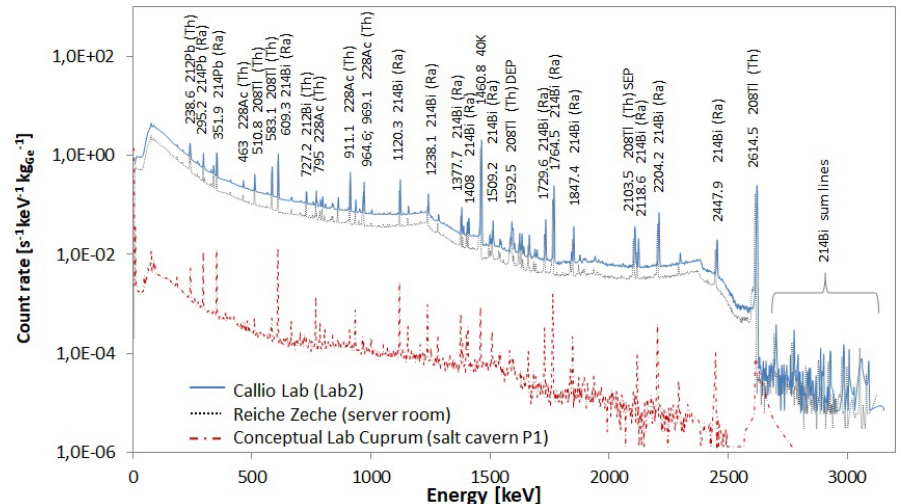
Figure 2. Comparison of background gamma-ray spectra collected at Reiche Zeche mine – server room (Polaczek-Grelik et al., 2019), Callio Lab – Lab 2 (Polaczek-Grelik et al., 2020), and Conceptual Lab development co-ordinated by KGHM Cuprum R&D centre – salt cavern P1 (Polaczek-Grelik et al., 2016), using gamma spectrometry and the same HPGe GR4020